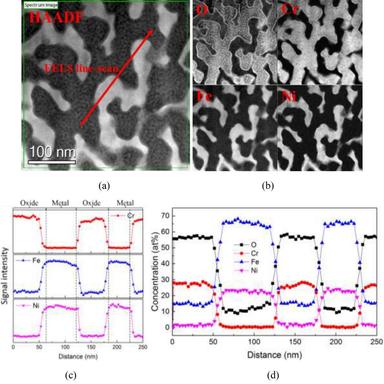
Morphology and chemistry of the two-phase structure in TEM sample 2. (a) HAADF image showing the morphology of the inner oxide layer (TEM sample 2); (b) EELS qualitative chemical composition maps showing the distribution of O, Cr, Fe, and Ni; (c) qualitative and (d) quantitative EELS chemical composition line-scan showing the distribution of O, Cr, Fe, and Ni.